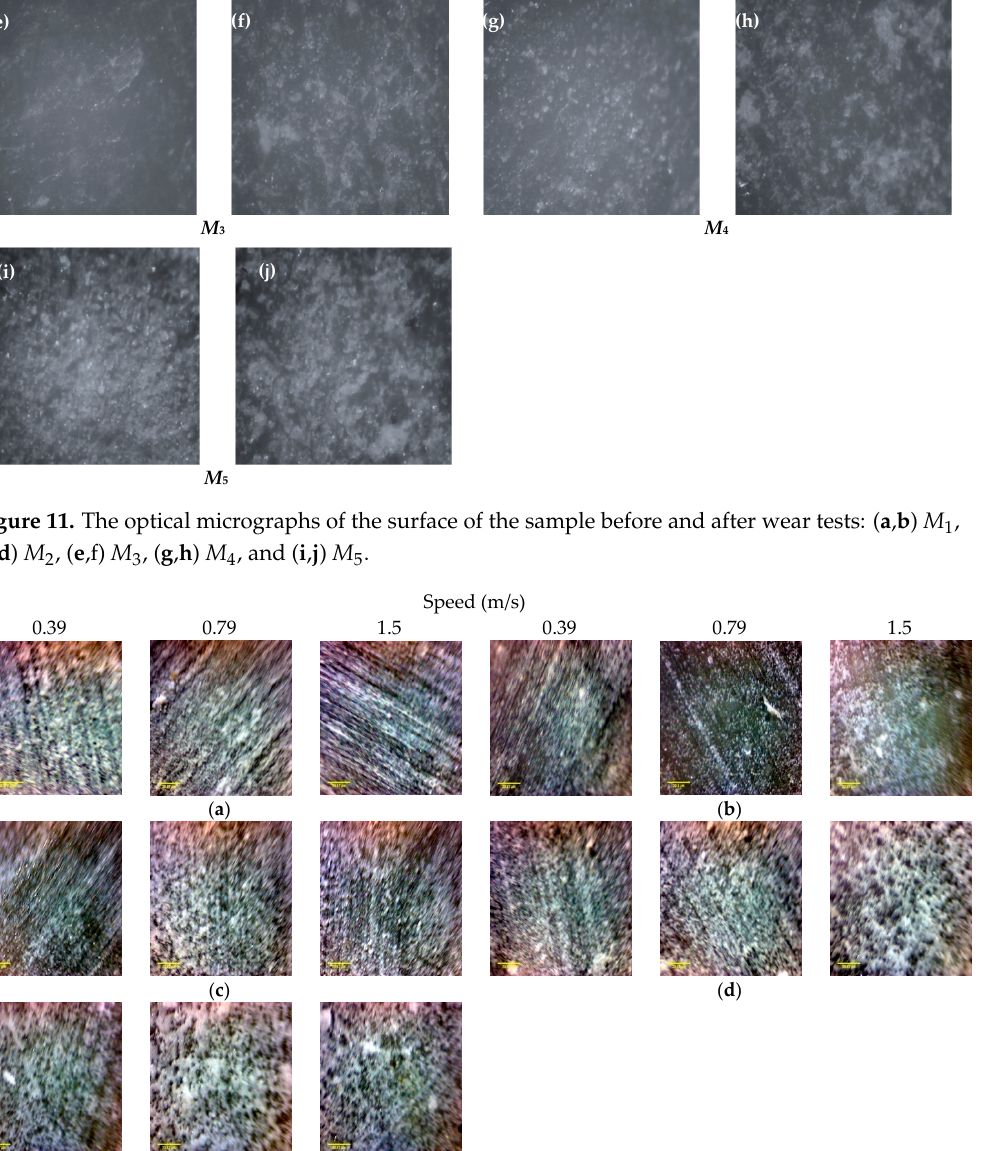
Figure 12. The optical micrographs of the worn surfaces of investigated samples under a normal load of 30 N at various sliding velocities for ( a ) the neat epoxy, M 1 , ( b ) M 2 , ( c ) M 3 , ( d ) M 4 , and ( e ) M 5 .